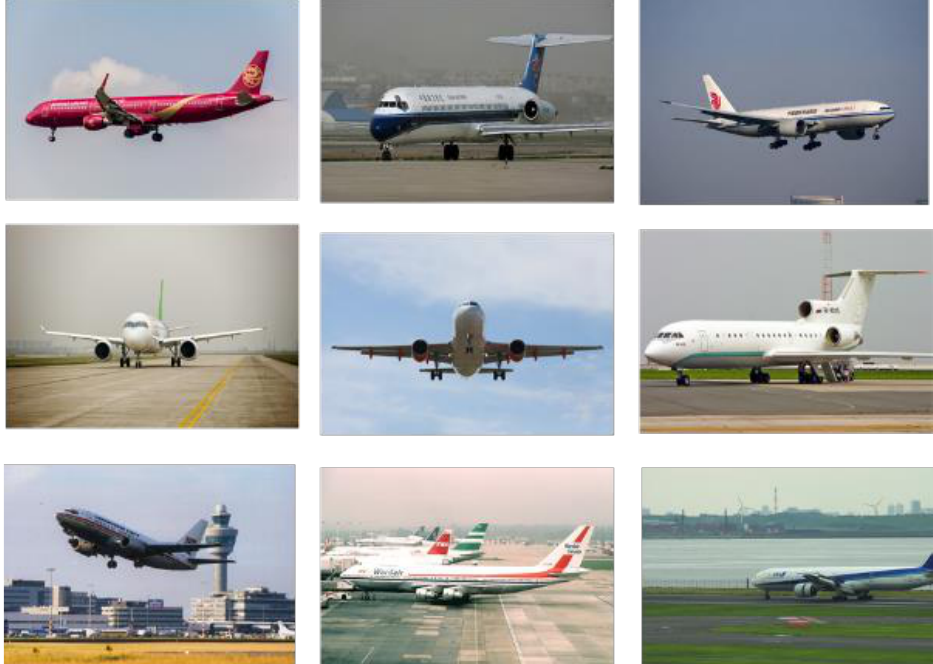
Figure 1. AP-DATA (includes 7000 aircraft images of different attitudes).